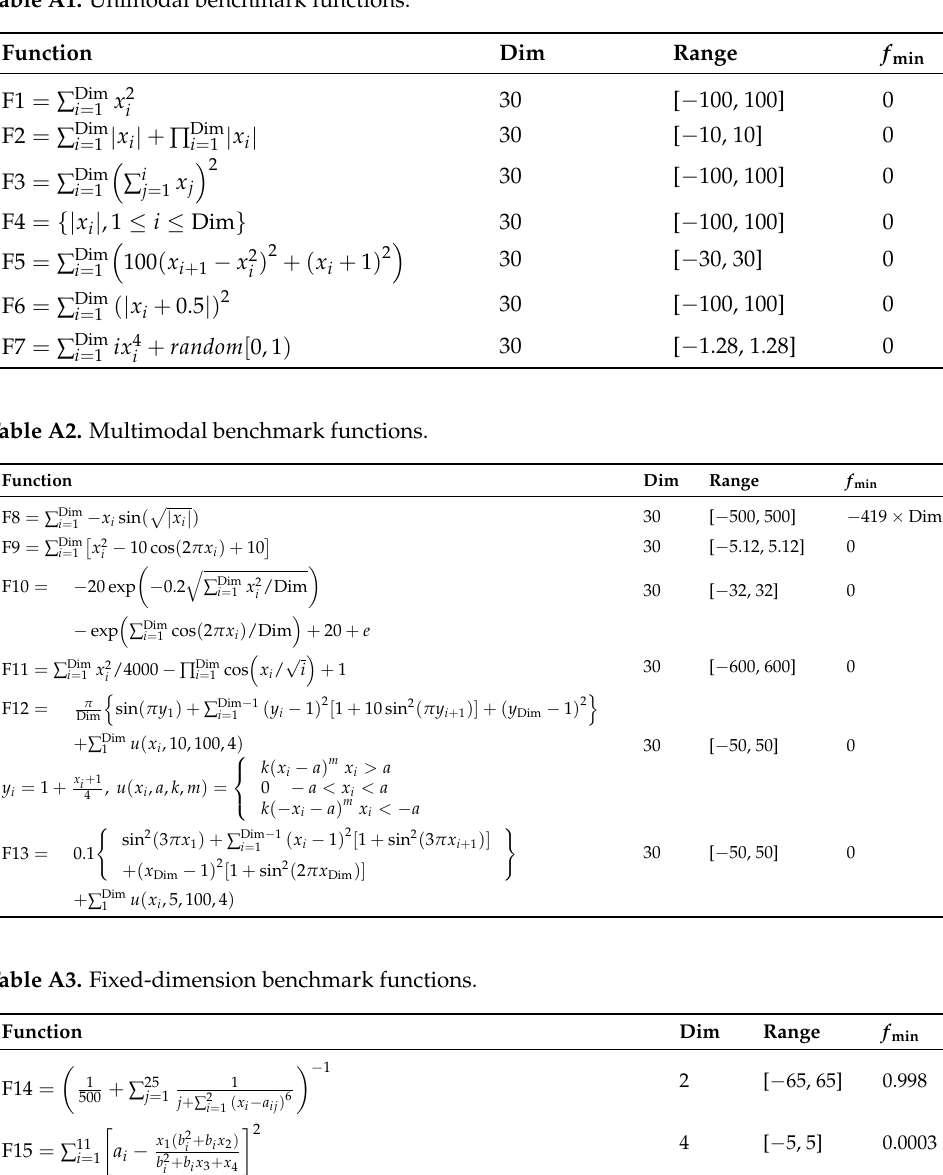
Table A1. Unimodal benchmark functions.